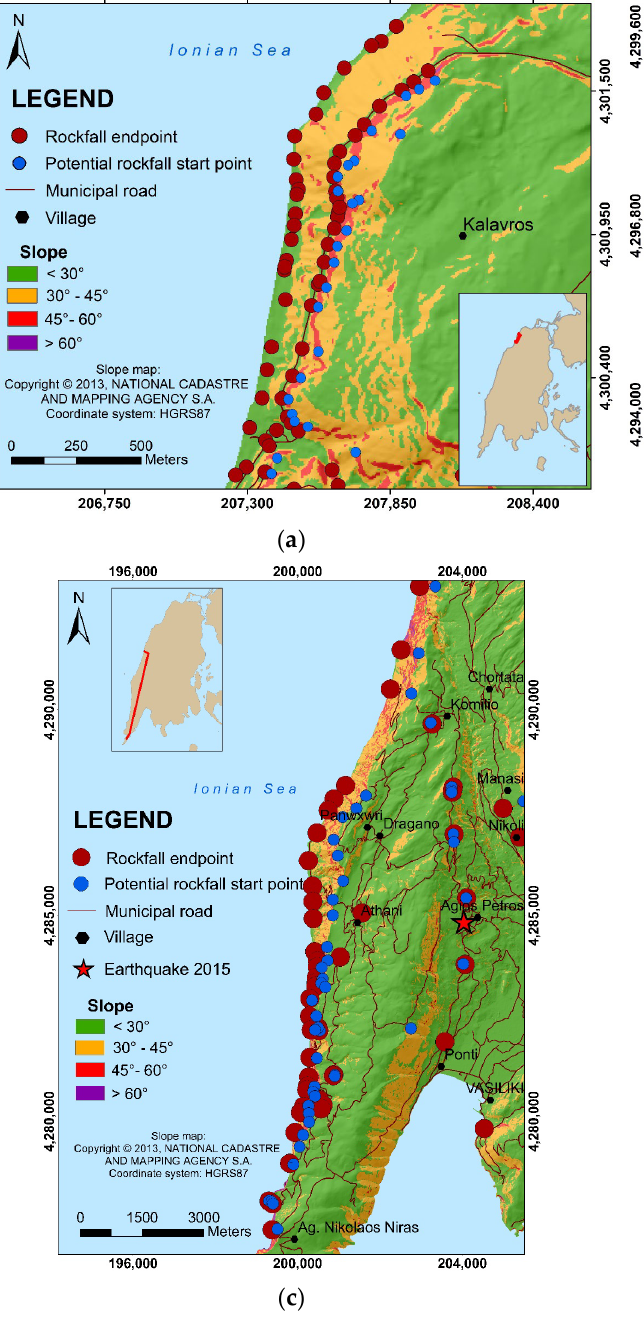
Figure 4. Rockfall Inventory maps on the island of Lefkada for ( a ) area A, ( b ) area B, ( c ) area C (map in the Greek Geodetic Reference System—GGRS87).